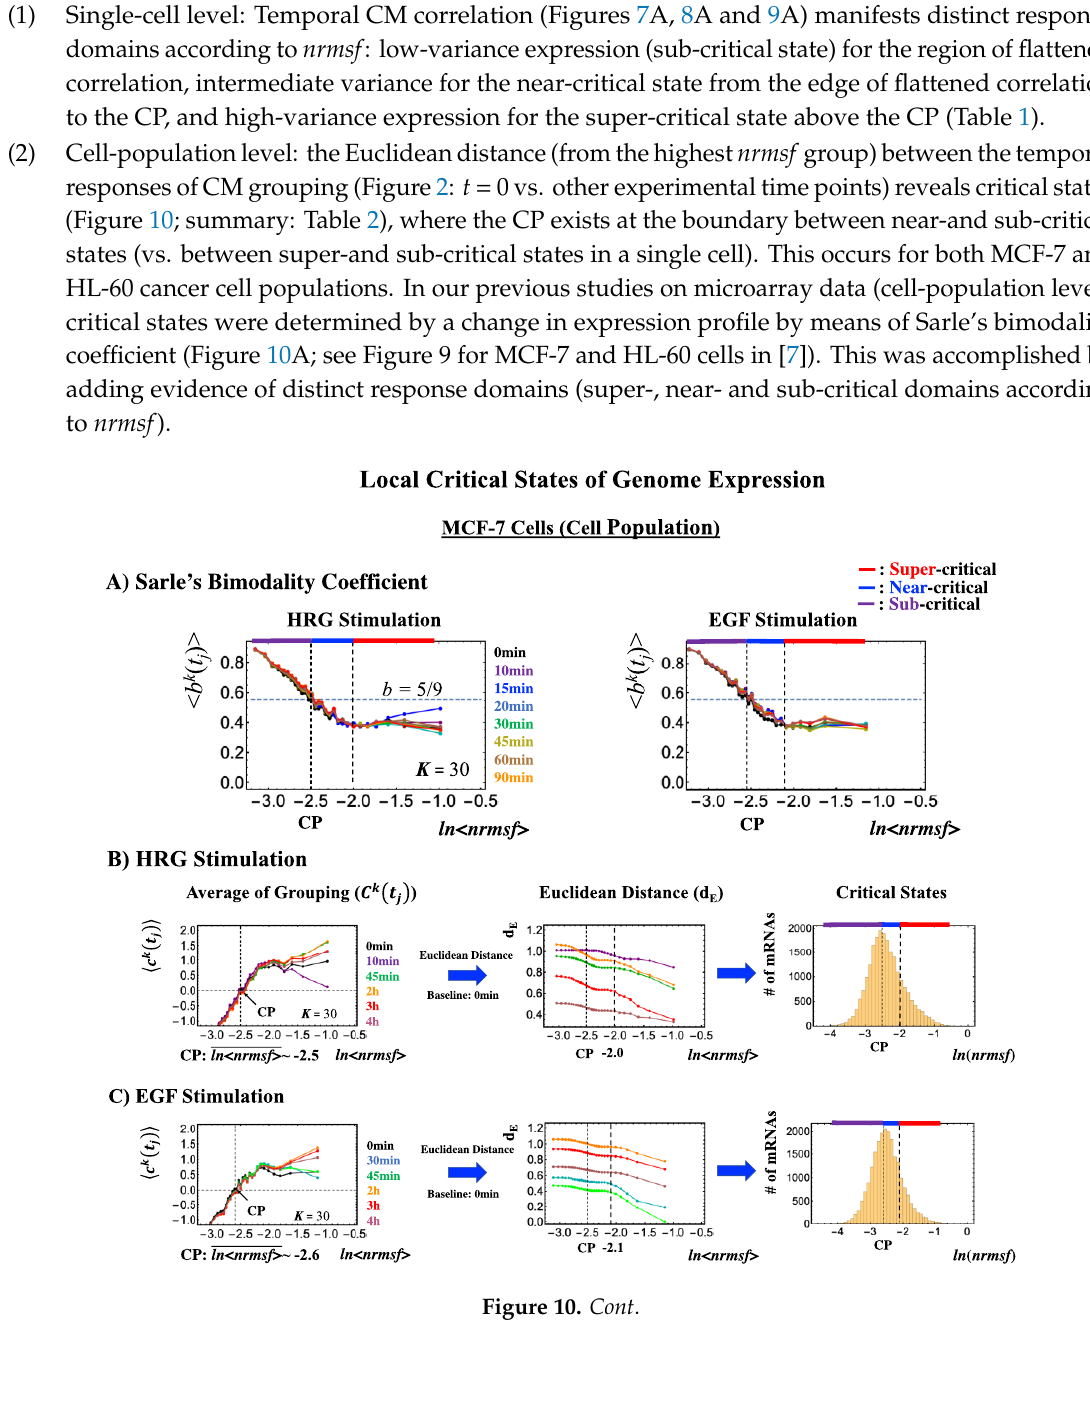
Figure 10. Systemic determination of local critical states for a cell population (microarray data). ( A ) In MCF-7 breast cancer cells, Sarle’s bimodality coefficient ( b >5/9: onset of bimodal profile) shows that around the CP, a unimodal-to-bimodal transition (from high to low nrmsf ) occurs for the group expression profile ( K = 30: n = 742 mRNAs), which reveals three distinct profiles (red: super-; blue: near-; purple: sub-critical state) in whole-genome expression (left: HRG stimulation; right: EGF